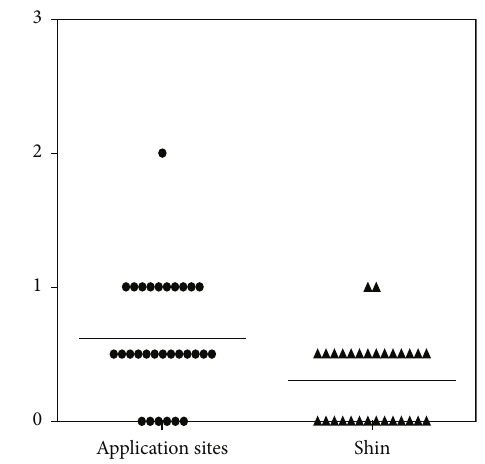
Figure 2: The skin irritation score of the post-RTP group was significantly lower in the pre-RTP group ( p < 0 . 05).